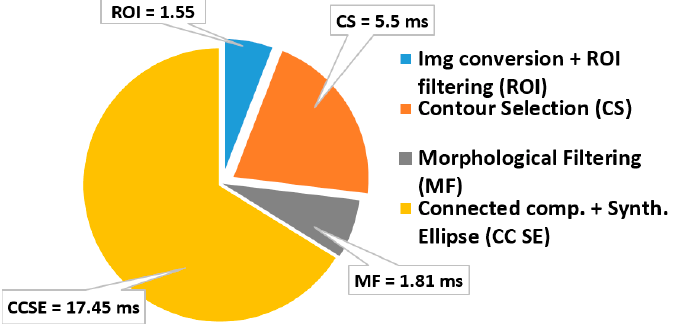
Figure 15. The time breakdown of the geometrical inspection algorithm when running on the embedded system of Figure 11.